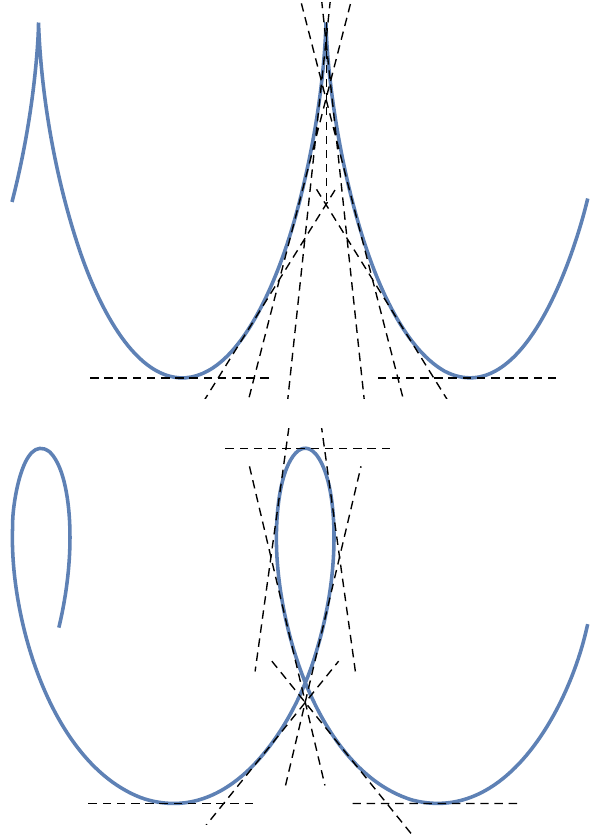
Fig. 23 The turning number contributions from a spike (top) and a loop (bottom)